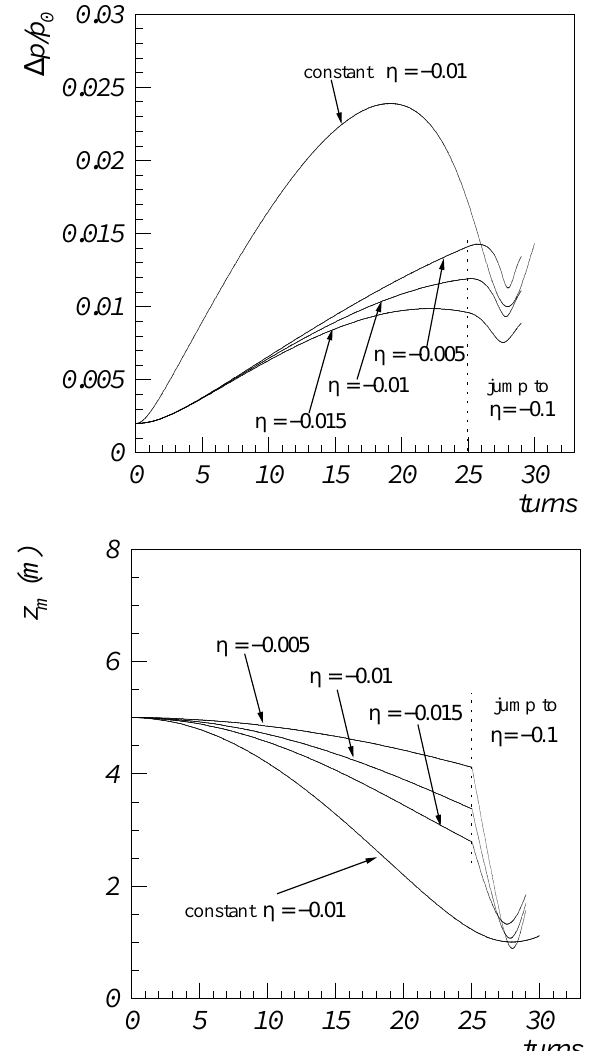
FIG. 5. Momentum spread and envelope for the h -jump case (iii), with h (cid:1) 2 0.01 (cid:2) 2 0.1